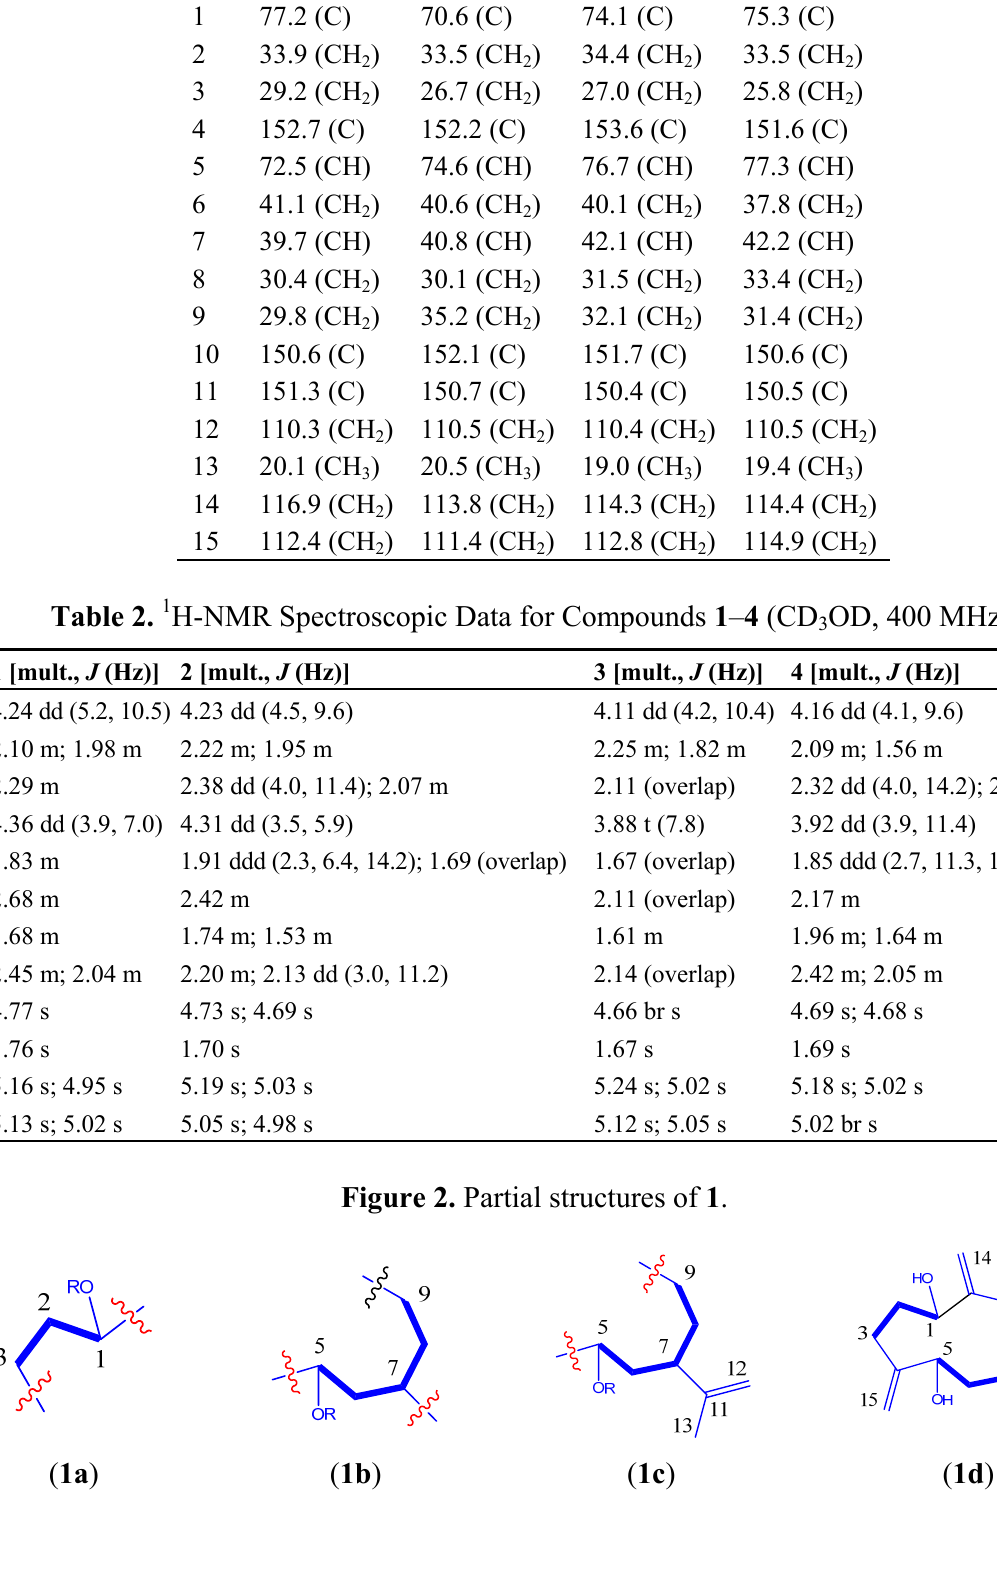
Table 1. 13 C-NMR spectroscopic data for compounds 1 – 4 (CD